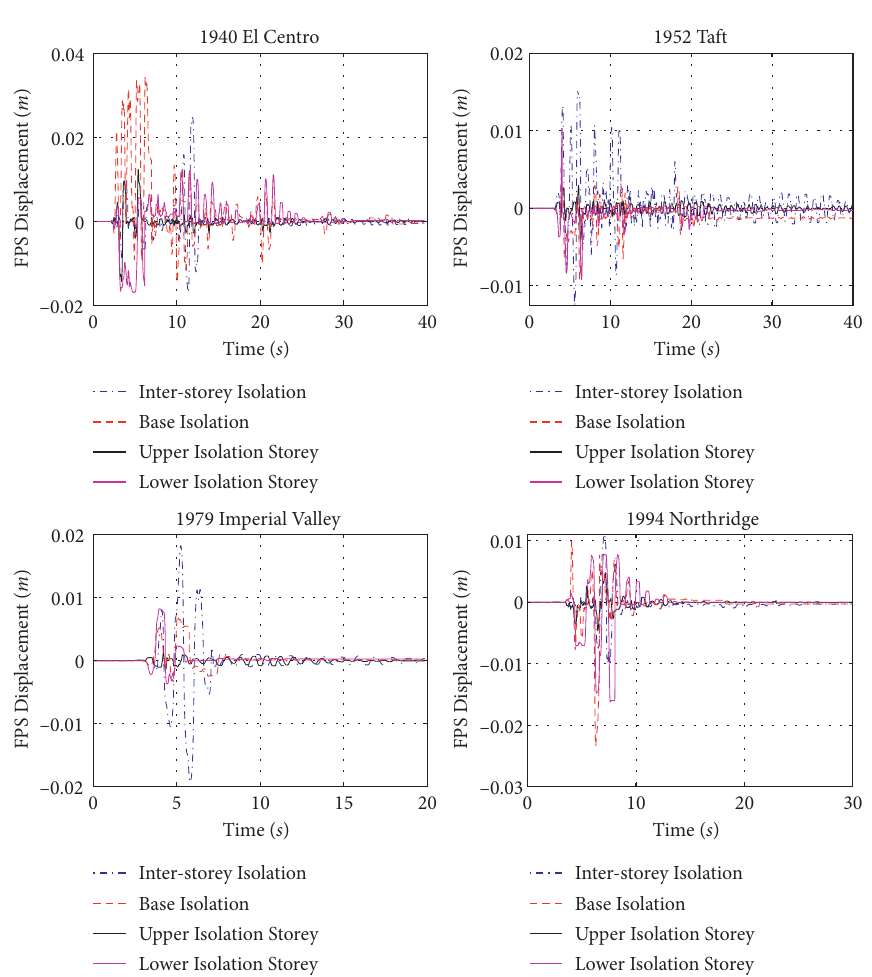
Figure 14: Displacement curve of the FPS